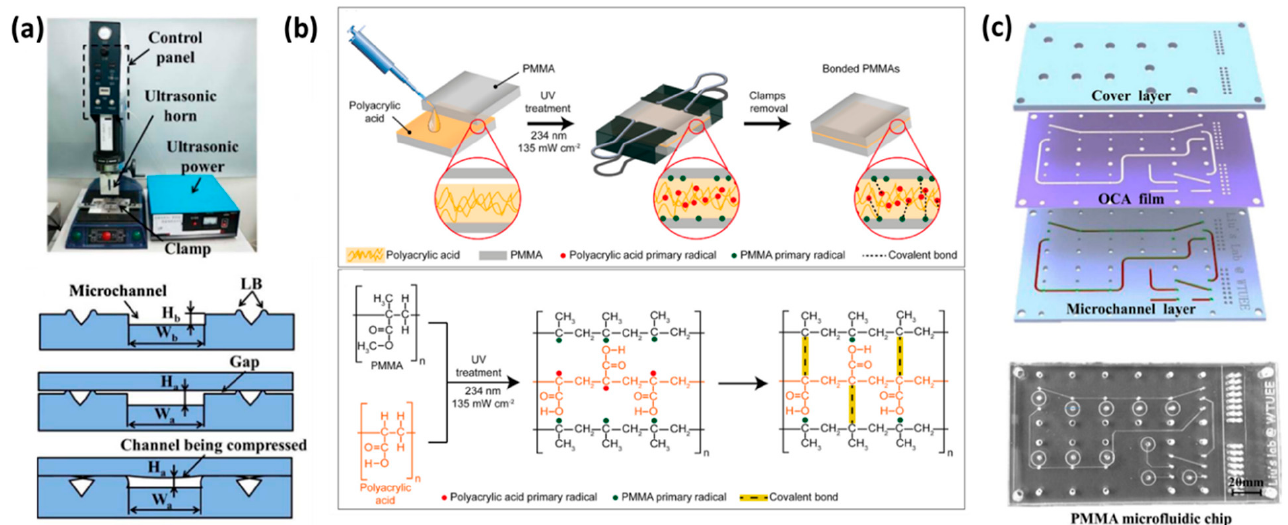
Figure 4. ( a ) Ultrasonic welding apparatus. In the microchannel design, the laser ablated grooves and bulges can create strong bonding and secure the melted polymer during the ultrasonic welding. Reproduced with permission [130] 2022, Elsevier. ( b ) Bonding PMMA layers through UV-curable PAA adhesive layer. Reproduced with permission [94] 2022, Elsevier. ( c ) Thermal bonding of PMMA layers using an optically clear adhesive (OCA) film. Reproduced with permission [63] 2022, Springer. Table 2. Common strategies for bonding microfluidic layers.